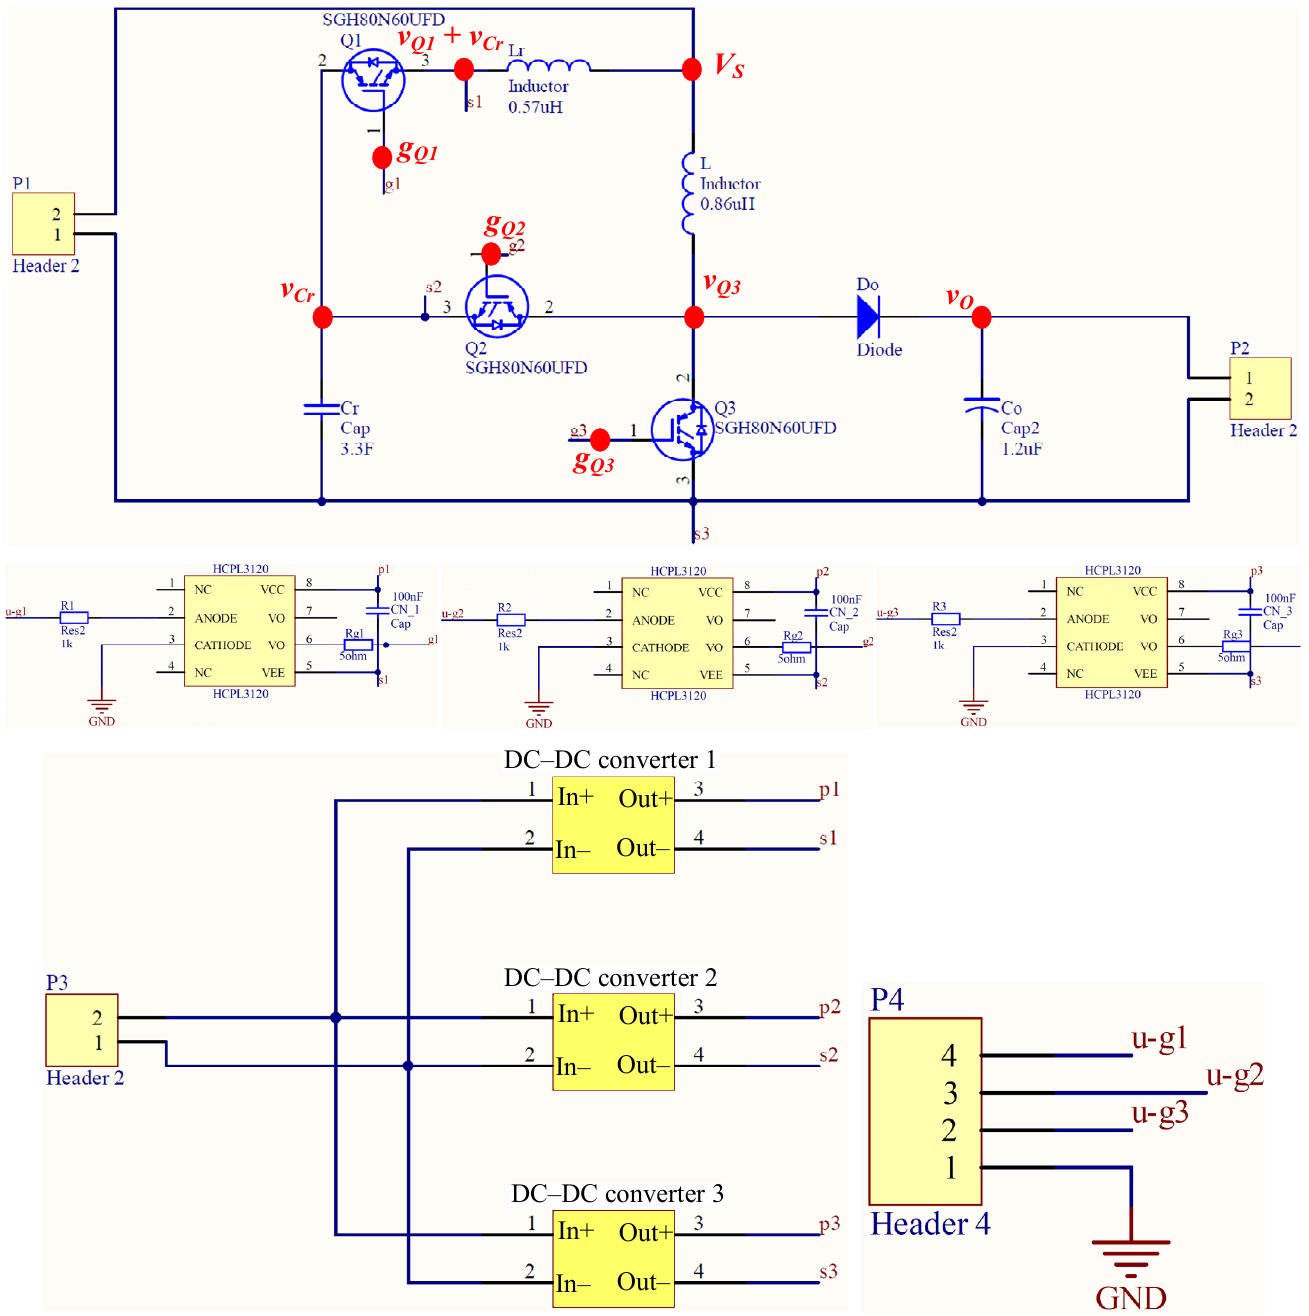
Figure 11. Schematic of the proposed converter.